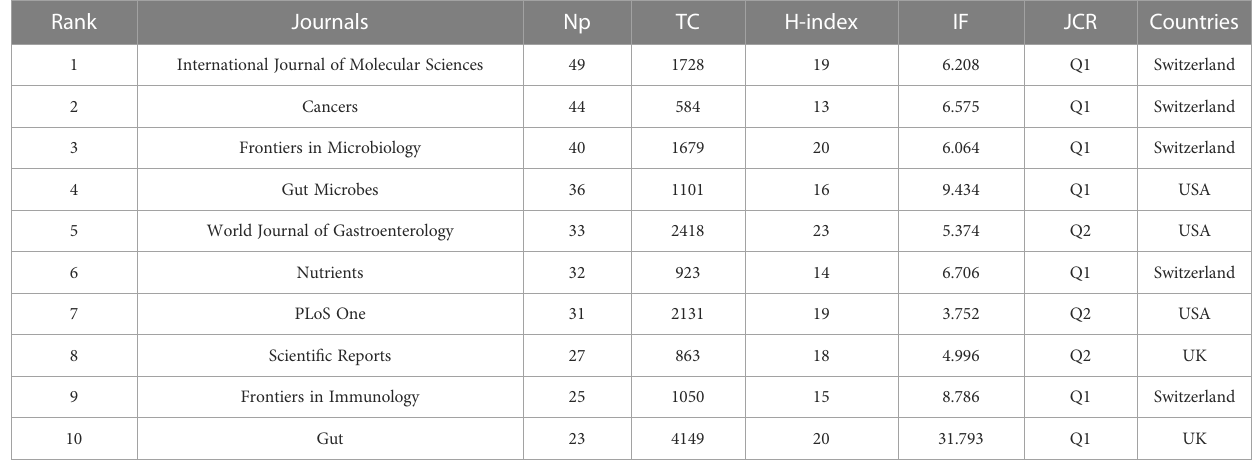
TABLE 1 The top 10 productive journals in IM/CRC.